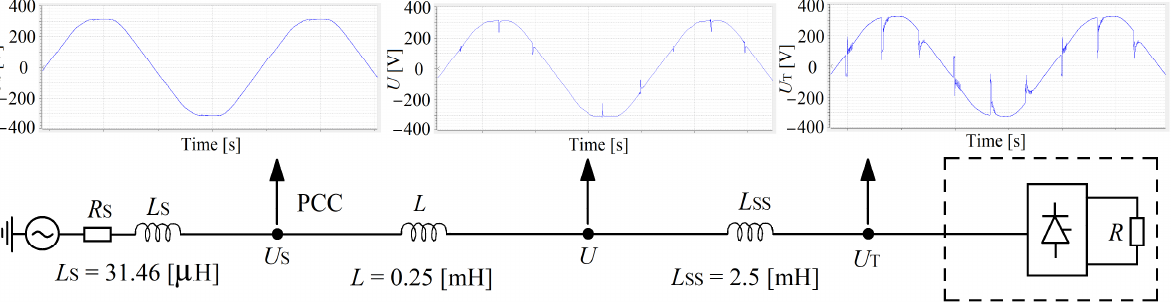
Figure 43. Voltage waveforms measured at different points of laboratory model. The influence of the